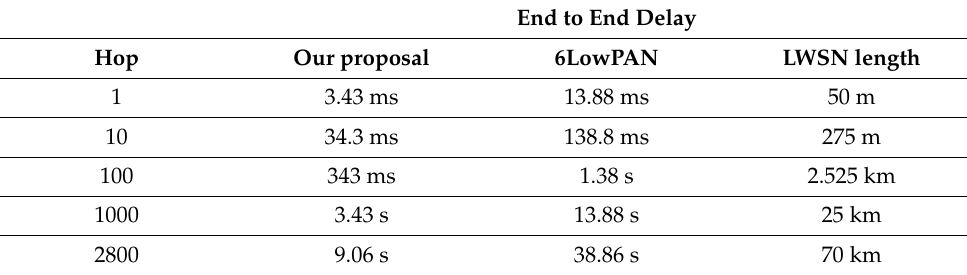
Table 8. Comparison of the end-to-end delay between 6LowPAN and our